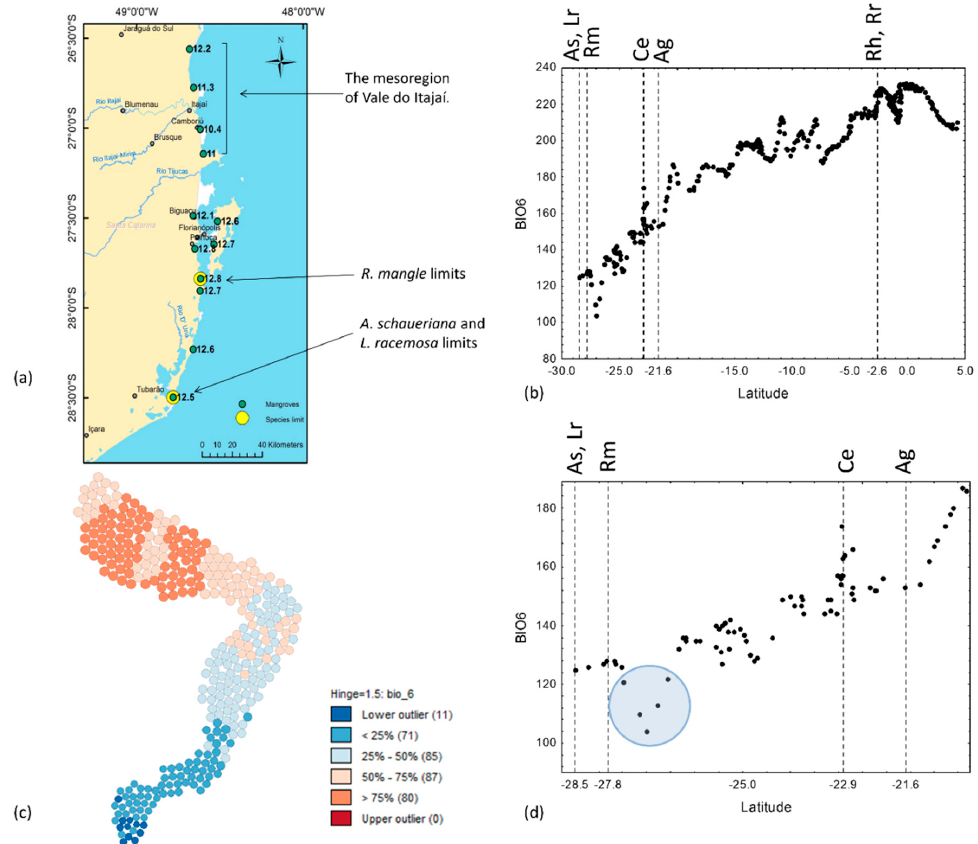
Figure 5. Detailed description of the Min temperature of coldest month (BIO6) (°C × 10) for mangroves in Brazil. ( a ) Detailed map of the south limits with their BIO6 values for each location of mangroves; ( b ) Scatterplot ( n = 334) representing the BIO6 by latitude in decimal degree superimposed on species distribution limits of (vertical dashed lines from the right to the left) R. racemosa (Rr) and R. harrisonii (Rh) (at 2.6°S), A. germinans (Ag) (at 21.6°S), C. erectus (Ce) (at 22.9°S), Rhizophora mangle (Rm) (at 27.8°S), and finally A. schaueriana (As) and L. racemosa (Lr) (together at 28.5°S). The vertical dashed lines from the right to the left can therefore be seen as the increasing richness of mangrove trees species; ( c ) Cartogram map distorted by the high and low values of BIO6. Each circle represents a mangrove sample point location (however distorted), the circle size overstates the value of the variable (here BIO 6), and the circle color represents the lower outliers, the lower quartile, the inter-quartile range (split into an upper and lower part), the upper quartile and the upper outliers, in exactly the same way as a Box and Whisker plot. The legend also shows the number of samples per color between brackets; ( d ) Scatterplot of BIO6 with a detailed zoom on the surrounding of the southernmost species distribution limits (vertical dashed lines of the species limits) and the blue circle indicates the mesoregion of Vale do Itajaí with the lowest values of BIO6 in the Brazilian mangroves.